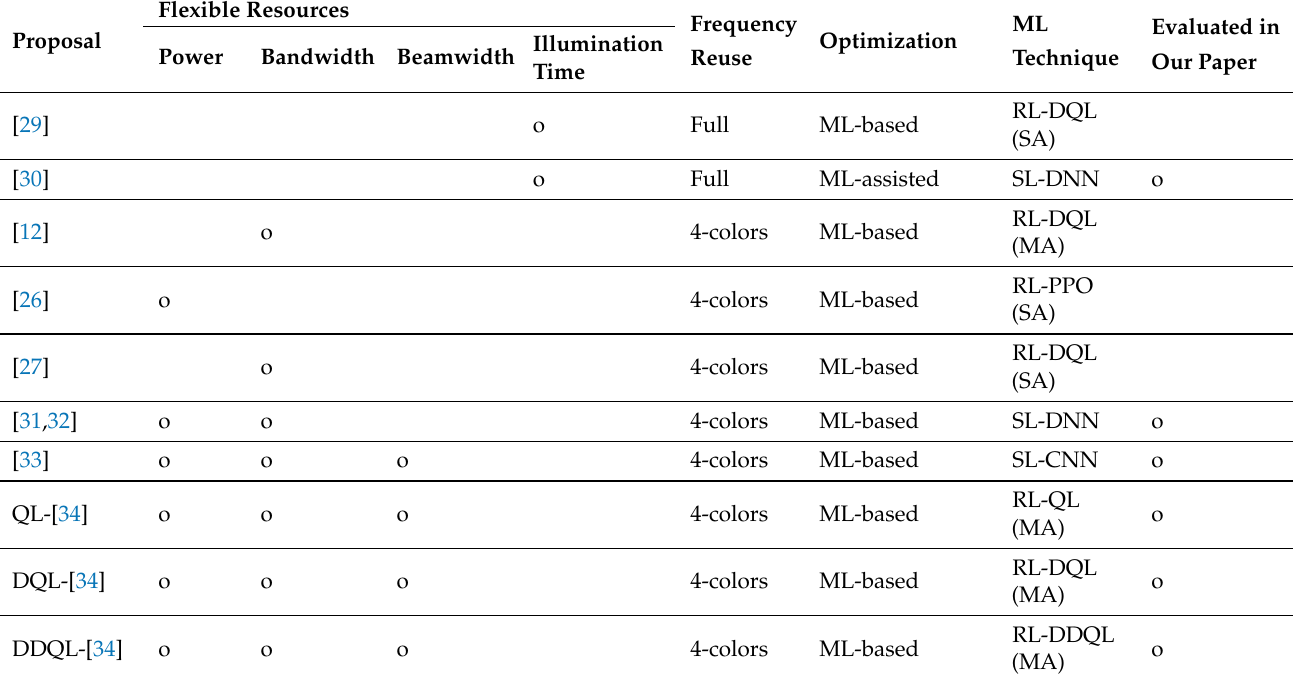
Table 2. ML model proposals features in SoA for multibeam satellite radio resources management. Flexible Proposal